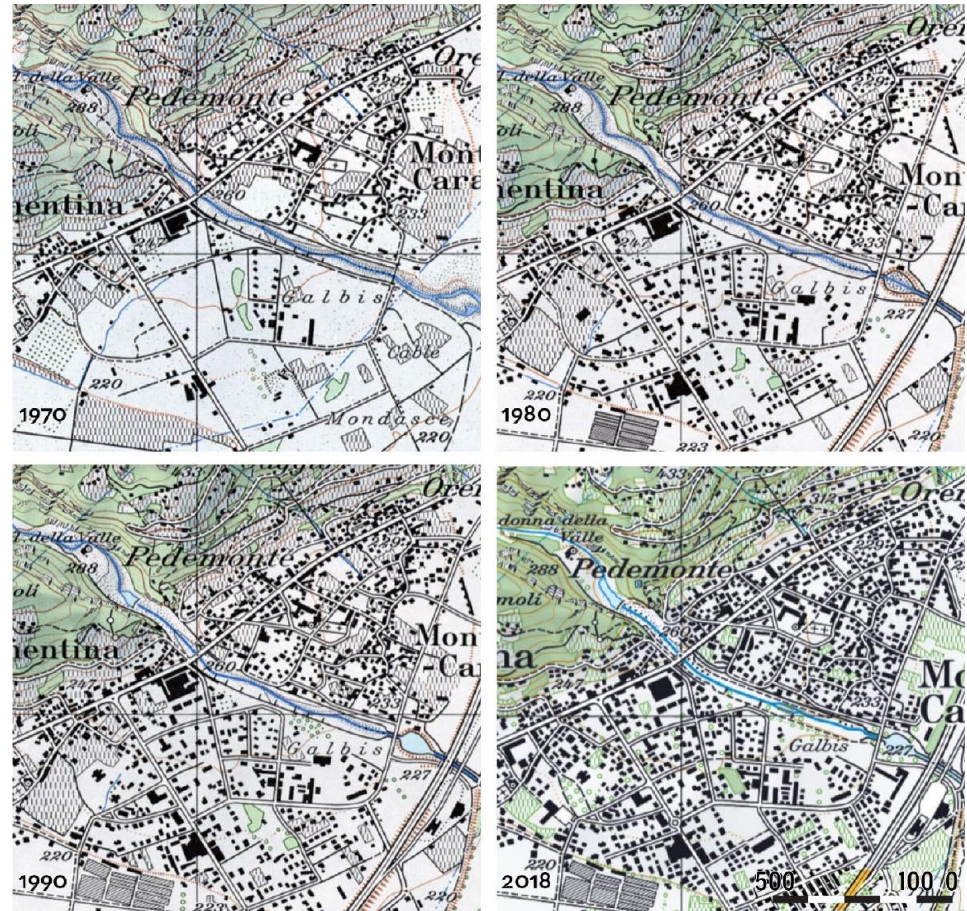
Figure 1. Topographic map of two settlements divided by the Sementina stream: Monte Carasso (northeast) and Sementina (southwest) successively from 1970, 1980, 1990, and 2018. Source: Swis- stopo 2021.